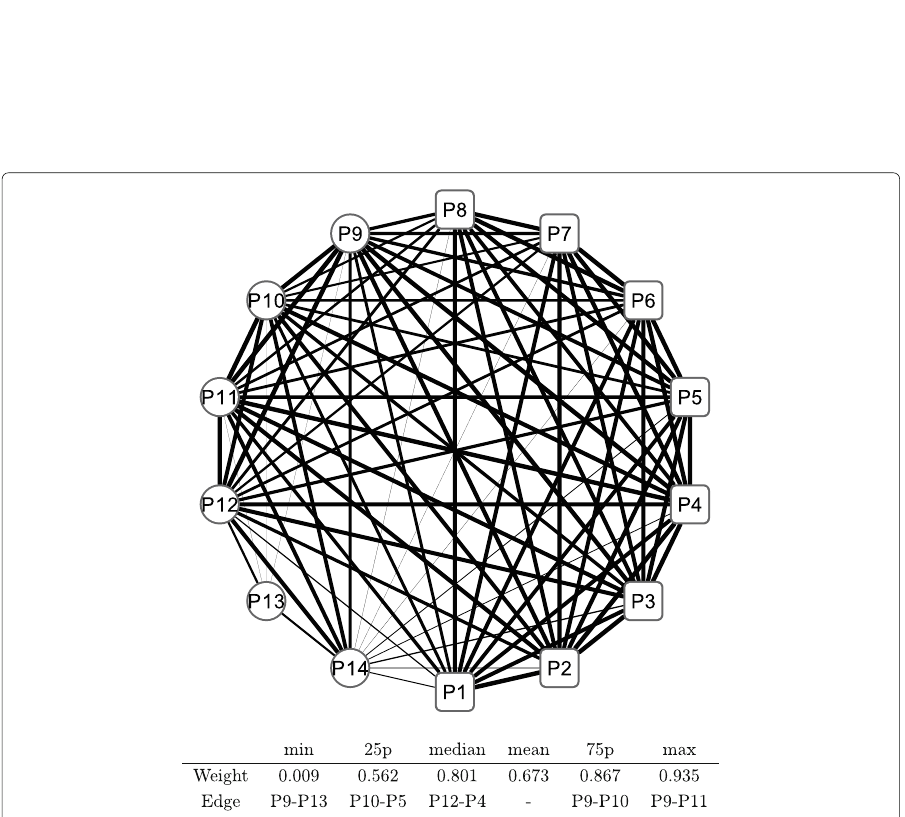
Fig. 10 Correlation network of sub-portfolios: sub-period T2. Note: The network is created based on the network adjacency matrix of the sub-period category T2. For further details, see the note of Fig.